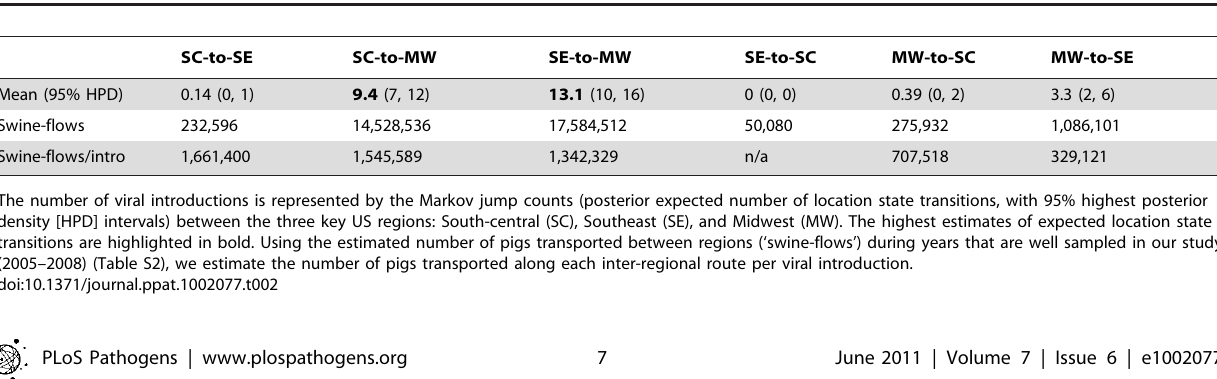
Table 2. Viral migration patterns.